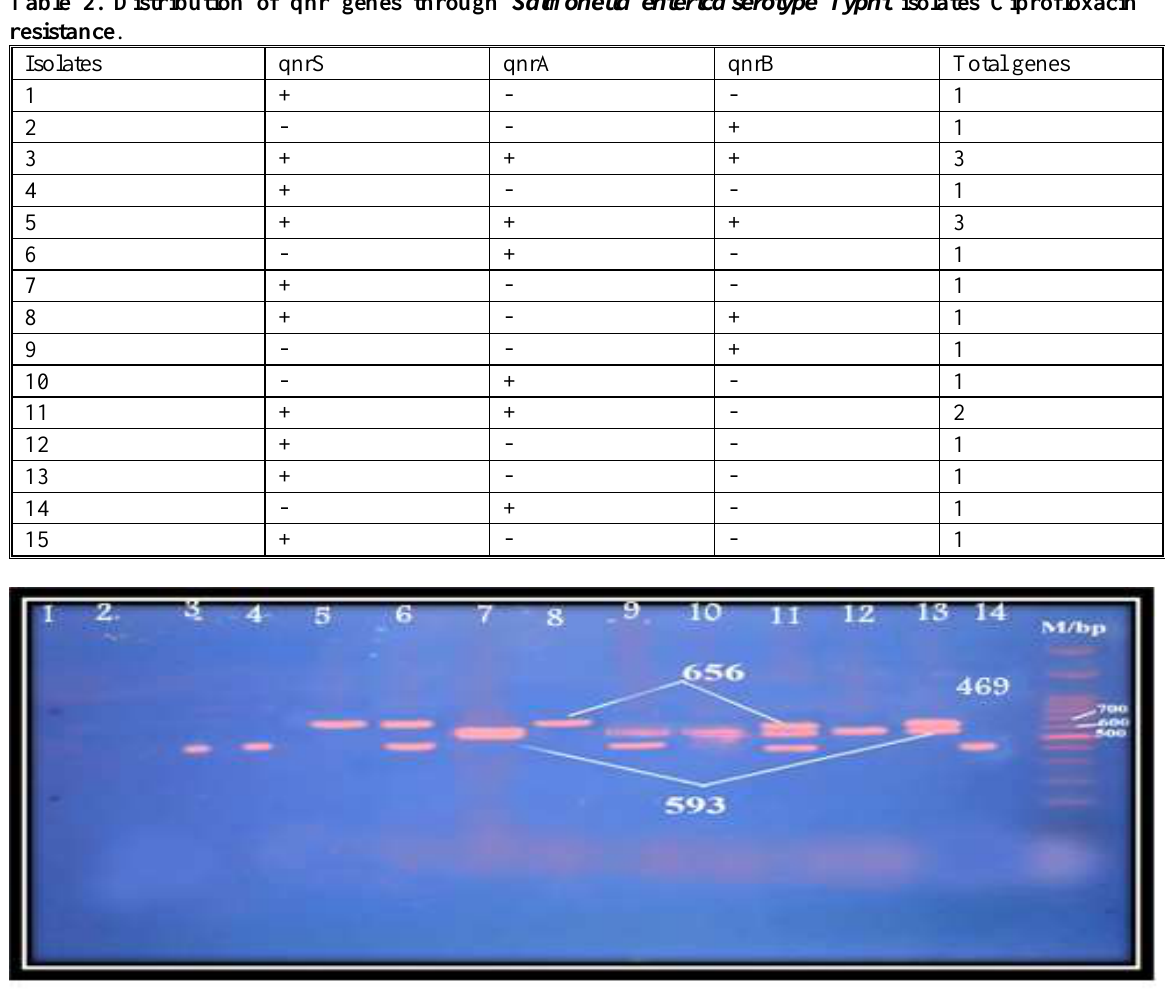
Figure 1. Gel electrophoresis of Multiplex PCR products (2% agarose, 7 v/cm 2 ,1.5hrs) for qnr A, qnr B, qnr S of Salmonella enterica serotype Typhi positive isolates. lanes 7, 9, 10,11, 12 and 13 qnr A gene (593 bp) positive isolates; lane 3,4,6,9,11,14: qnr B (469 bp) positive isolate; lanes 5,6,8,11,13 qnr S (656 bp) positive